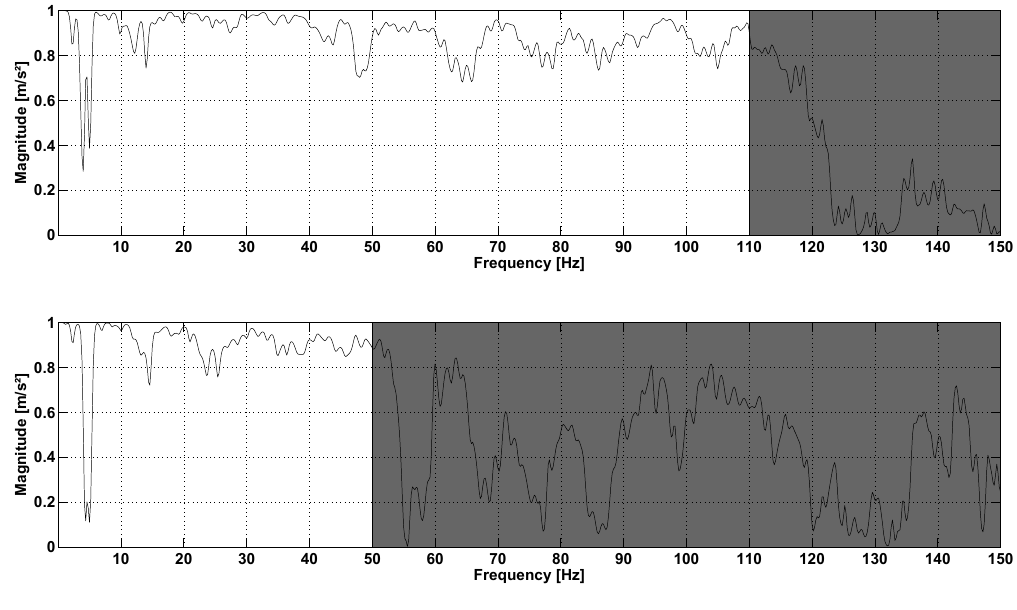
Figure 9. Spectral coherence between R 1344 and H 1344 at 12 km/h ( Top ) and between R 400 and H 400 at 18 km/h ( Bottom